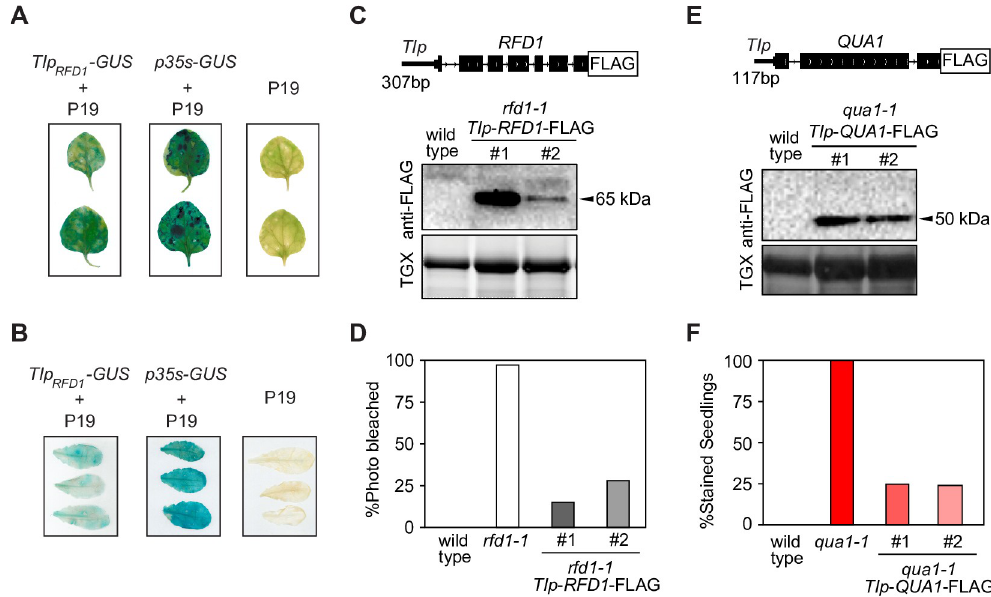
Fig 2. The act of upstream transcription represses a functional downstream promoter. (A) Transient expression of the GUS reporter gene under the control of TIp RFD1 in N . benthamiana leaves. p35s-GUS and p19 (lacking GUS reporter gene) are used as positive and negative controls for GUS expression, respectively. (B) Transient expression of GUS reporter gene under the control of TIp in leaves of the A . thaliana efr mutant. p35s-GUS and p19 (lacking GUS reporter gene) are used RFD1 as positive and negative controls for GUS expression, respectively. (C) Detection of RFD1-FLAG protein expressed from TIp RFD1 -RFD1-FLAG by western blotting. For loading controls, total protein levels were detected using TGX stain-free complements rfd1-1 photo-bleaching phenotype. Wild type protein gels. (D) Expression of RFD1-FLAG from TIp RFD1 (n = 84), rfd1-1 (n = 143), lines #1 (n = 1196) and #2 (n = 943) segregating for the TIp RFD1 -RFD1-FLAG complementation by western blotting. For loading controls, construct. (E) Detection of QUA1-FLAG protein from TIp QUA1 -QUA1-FLAG total protein levels were detected using TGX stain-free protein gels. (F) Expression of QUA1-FLAG from TIp QUA1 complements ruthenium red staining qua1-1 phenotype. Wild type (n = 97), qua1-1 (n = 96), lines #1 (n = 267) and #2 (n = 254) segregating for the TIp QUA1 -QUA1-FLAG complementation